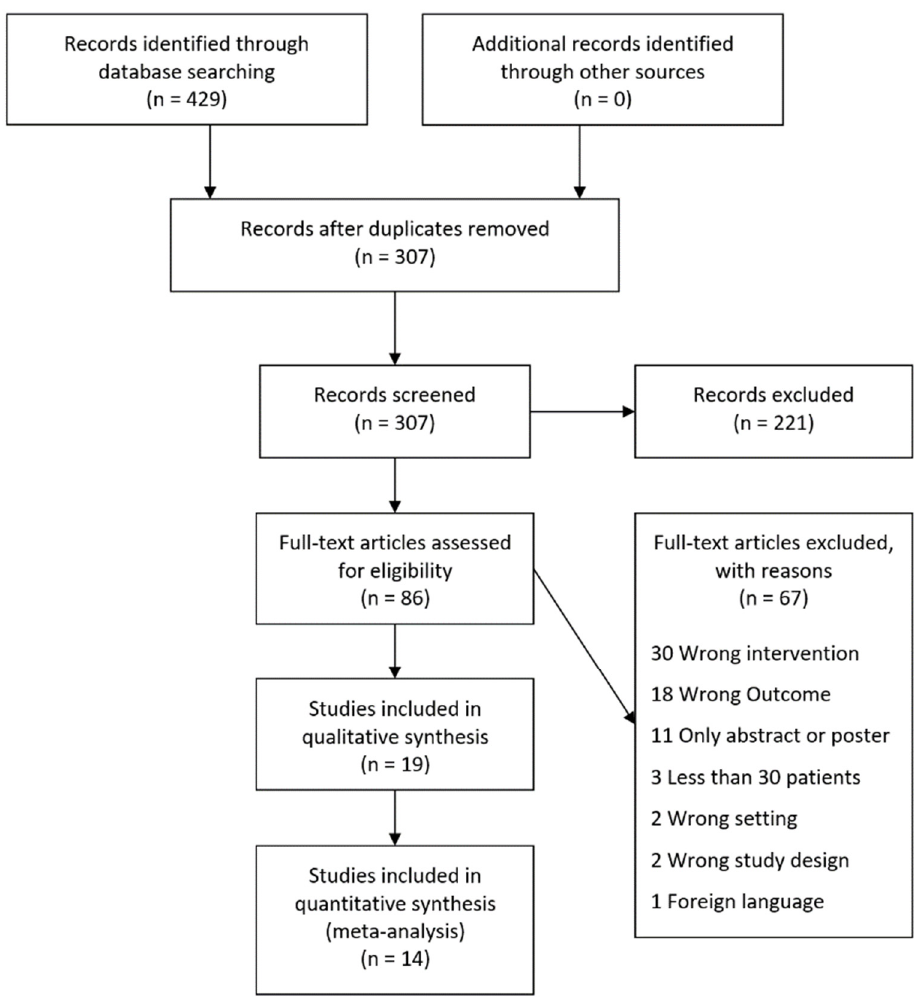
Figure 1. PRISMA flowchart. The literature search was performed using PubMed, Embase, The Cochrane Library, and Web of Science. Table 1. Main characteristics of the included studies. The density of TILs was assessed in the diagnostic biopsy using IHC with antibodies targeting specific subgroups of TILs. Different cut- off values were used to separate patients into high vs. low density of TILs. Treatment response was evaluated histopathologically using TRG. Treatment response was defined as pCR or pTR in most